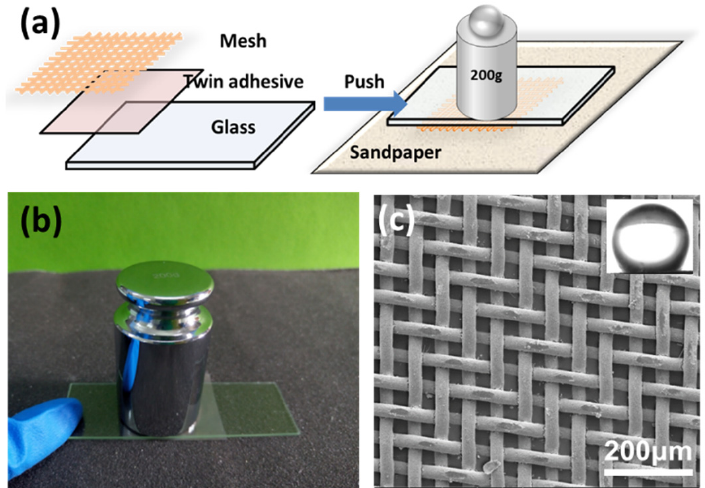
Figure 5. ( a ) Illustration of the abrasion test for the as-prepared copper mesh. ( b ) Photograph of the